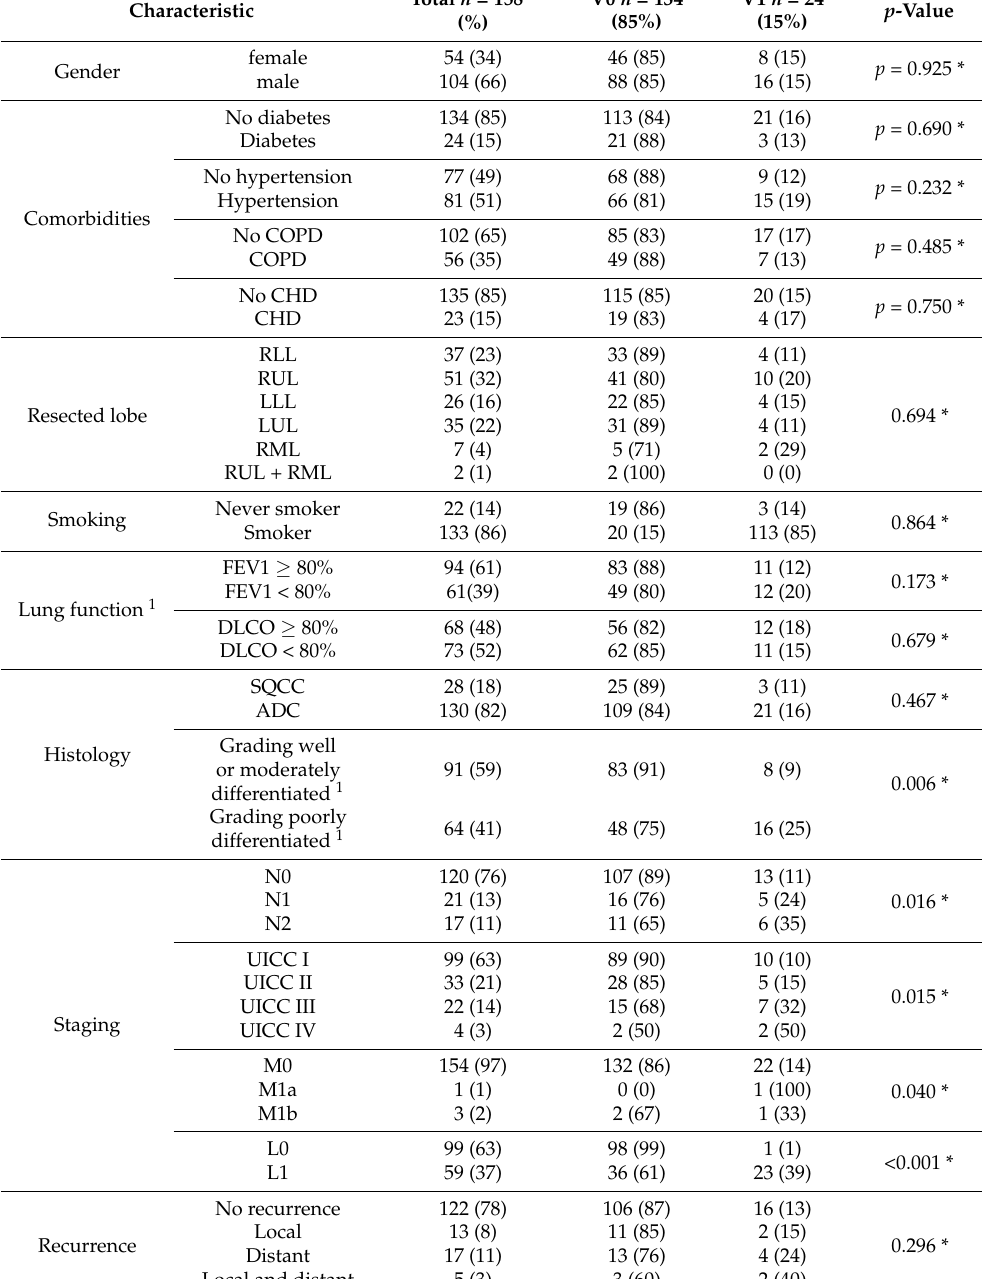
Table A1. Association of blood vessel invasion with the patients’ clinicopathological parameters ( n =